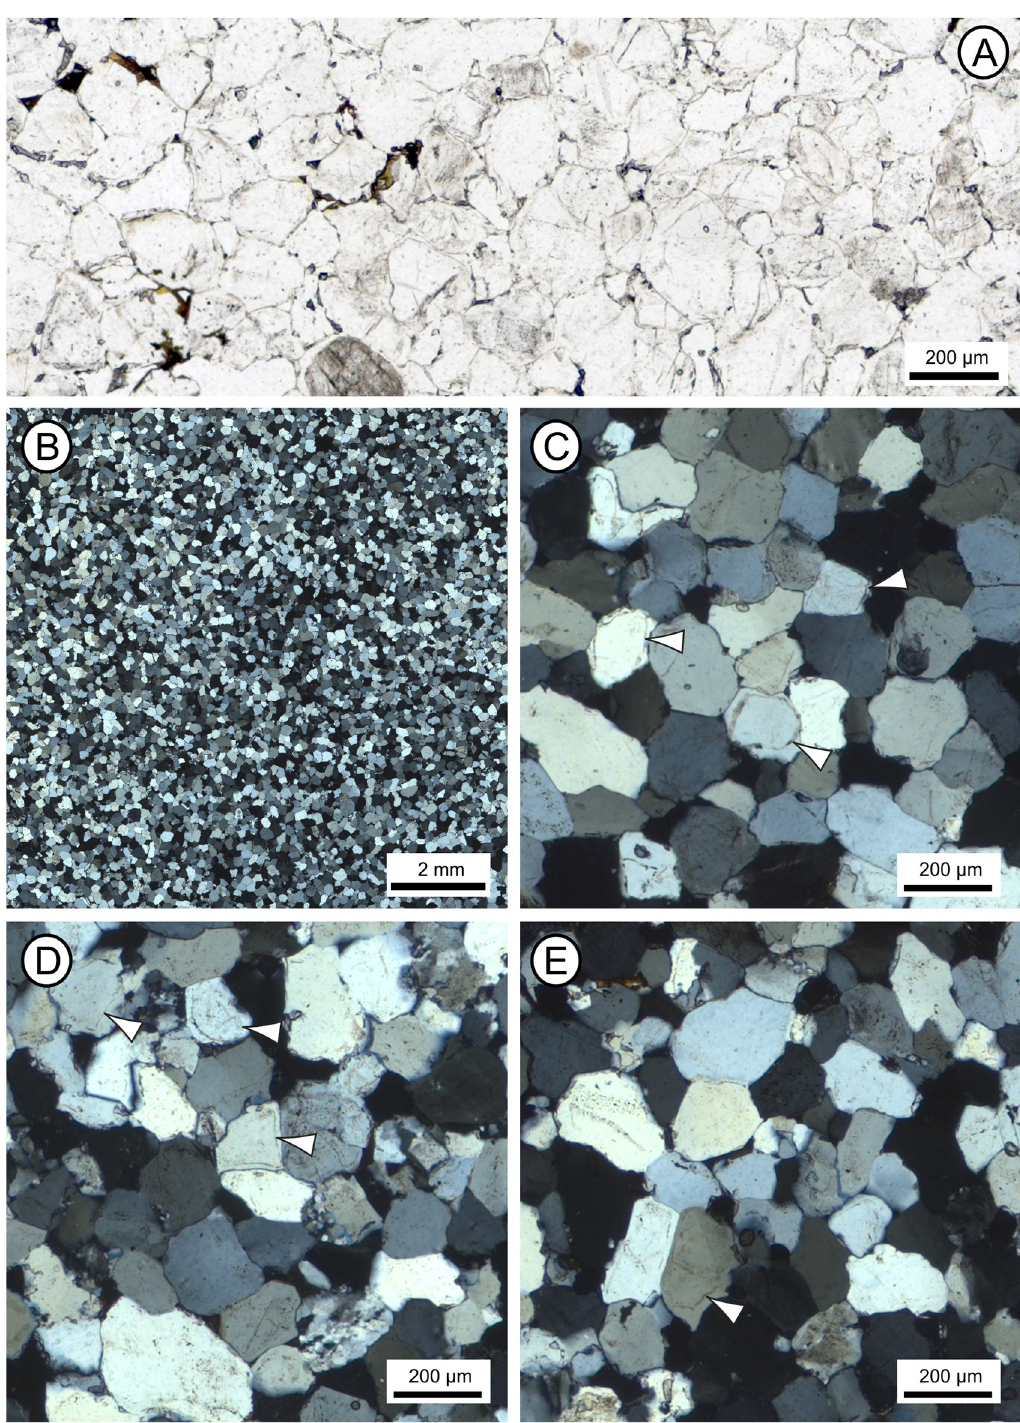
Fig 10. Optical images from polished thin-sections taken under plane- (A) and cross-polarised (B-E) light, illustrating the petrography of section 2–3 of the Phillips’ Core from Stone 58 at Stonehenge. (A) Detail of thin-section SH1B showing the typical sarsen fabric comprising quartz grains cemented by quartz overgrowths, with late-stage Fe-Ti minerals lining and/or infilling some void spaces. (B) Overview of thin-section SH2B showing the pervasive nature and uniformity of syntaxial optically-continuous quartz overgrowth cements. (C-E) Details of thin-sections SH1B (C), SH2B (D) and SH3B (E), showing host quartz grains, some of which enclose accessory minerals; dust lines (arrowed) mark the margin between some quartz grains and the quartz overgrowth cement in images C-E. These images are reproduced under a CC BY 4.0 license, with permission from The Trustees of the Natural History Museum, original copyright